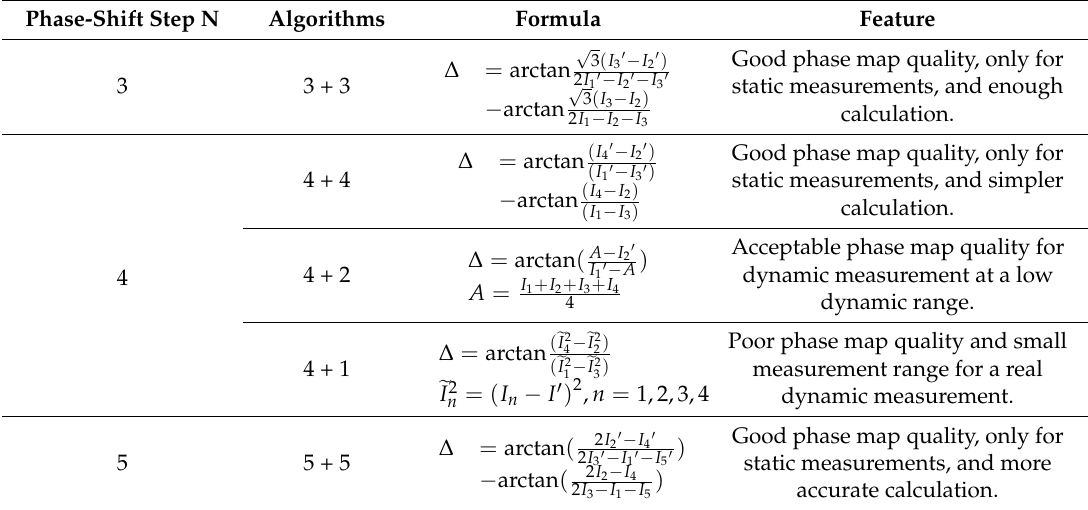
Table 1. The common temporal phase-shift